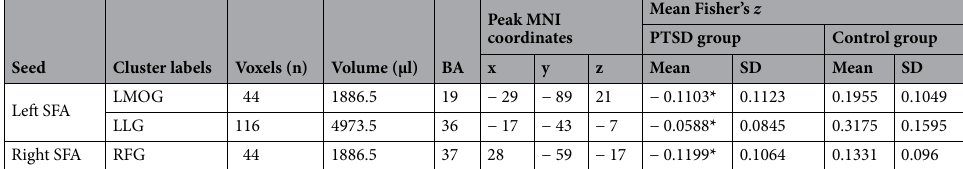
Table 2. Superficial amygdala (SFA): areas of negative association of SFA connectivity with PTSD group PCL-5 scores. BA brodmann area, MNI Montreal Neurological Institute, SD standard deviation, PTSD posttraumatic stress disorder, RFG right fusiform gyrus, LLG left lingual gyrus, LMOG left middle occipital gyrus. *Means statistically different from 0 in one sample t-test. All group differences represent significant differences between negative mean correlations (connectivity) in the PTSD group and the positive correlations in the control group. Cluster labels are for the regions that showed the significant difference in connectivity with the seeds. Differences are significant after correction for multiple comparisons (P <